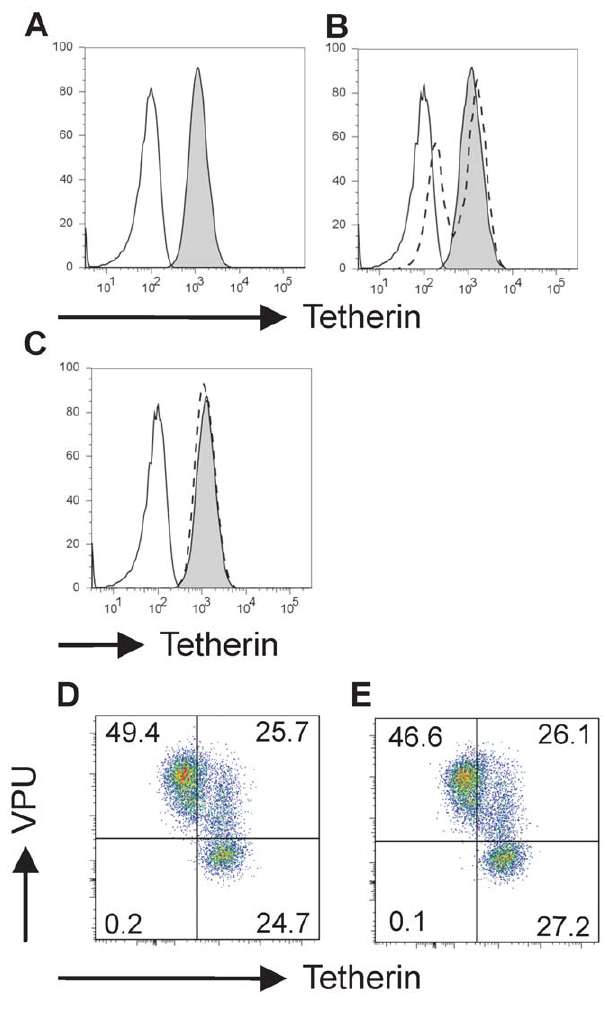
Figure 6. CAML does not regulate cell surface levels of tetherin. A rabbit polyclonal anti-tetherin antibody was used to quantify tetherin on the cell surface of HeLa cells by flow cytometry. A) Unstained cell control (white) and tetherin surface staining (filled histogram) using primary rabbit anti-tetherin followed by anti-rabbit APC staining. B) HeLa cells transduced with a control shRNA lentiviral vector (filled histogram) compared with unstained control cells (white). Dashed line indicates histogram of tetherin shRNA-transduced cells, demonstrating that cell surface levels were diminished by tetherin shRNA. C) Cell surface levels of tetherin in control shRNA transduced cells (filled histogram) did not differ from cells in which CAML was significantly depleted using CAML-specific shRNA (dashed lines). D) Vpu-EGFP transfected HeLa cells demonstrate cell surface downregulation of tetherin, as indicated by left shift of EGFP-positive population. E) CAML knockdown HeLa cells demonstrate cell surface downregulation of tetherin by Vpu-EGFP, similar to that shown in